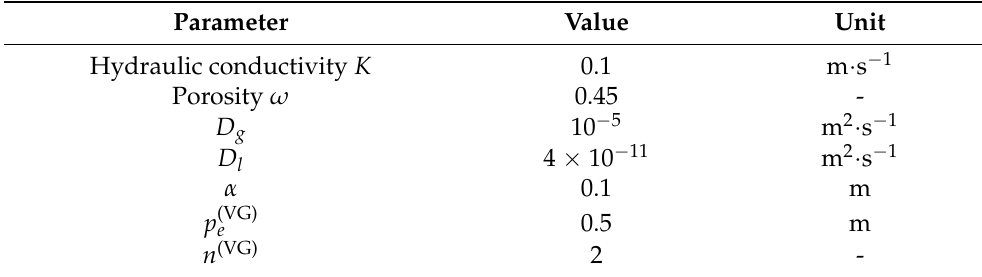
Table 1. Hydrodynamic and transport